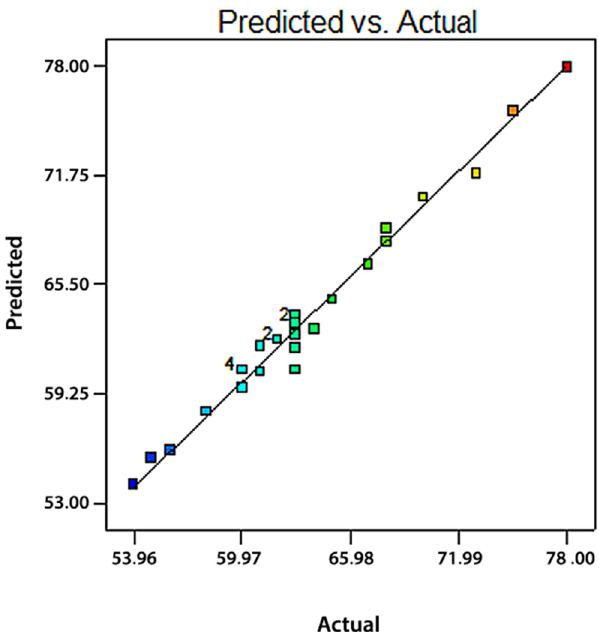
Fig 1. Predicted values versus actual values plot for the final mAb titre, It helps we detect a value, or group of values, that are not easily predicted by the model. The near 45 degree line of correlating plot shows the acceptable correlation between predicted and actual response